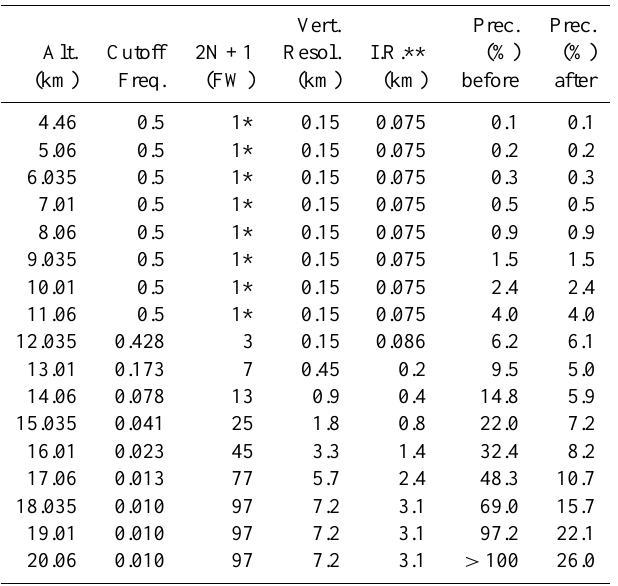
Table 1. Vertical filtering scheme (Kaiser filter, 50dB attenuation) applied to the high-intensity range for a typical 2-h integrated measurement, and resulting vertical resolution and precision. Vert. Prec. Prec. Alt. Cutoff 2N+1 Resol. I.R.** (%) (%) (km) Freq. (FW) (km) (km) before after 4.46 0.5